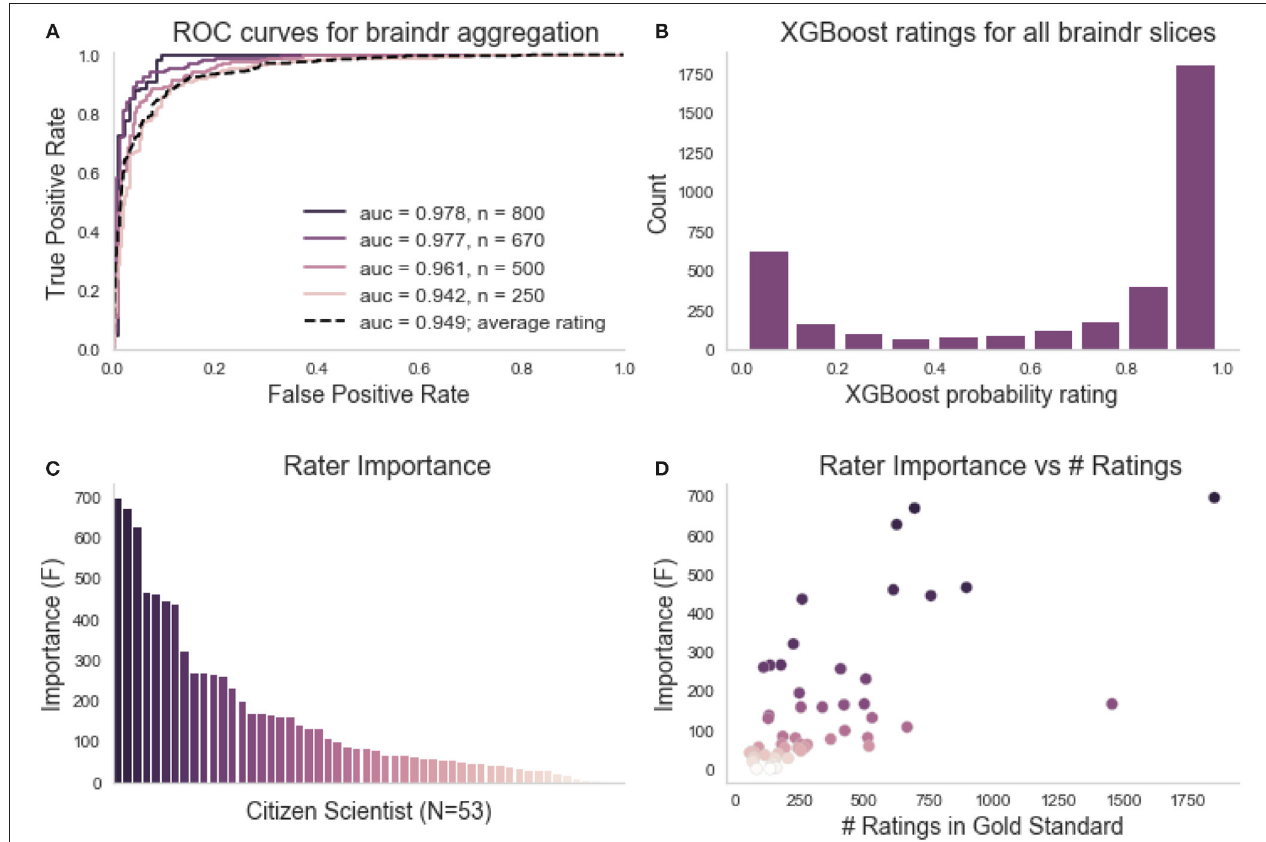
FIGURE 2 | Braindr rating aggregation and citizen scientist importance. (A) ROC curves on the test set for various training set sizes (here n denotes the number of training slices used). The dashed line is the ROC curve of the average citizen scientist ratings for all slices. (B) The distribution of XGBoost probability scores on all Braindr slices. (C) Feature importance for each anonymized user. (D) Relationship between citizen scientist importance and total number of ratings in the gold-standard